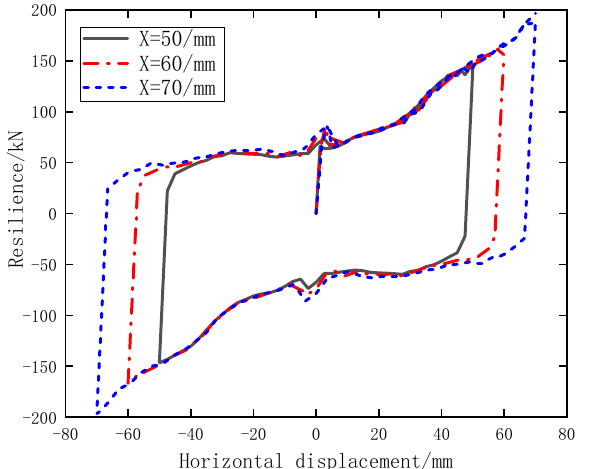
Figure 13. Hysteresis curves of SMA-negative stiffness hyperboloid shock absorber at different horizontal displacements.